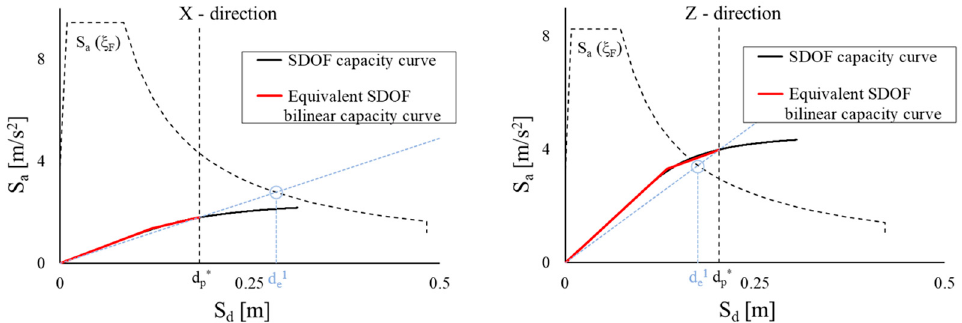
Figure 6. Comparison of the equivalent SDOF bilinear capacity curves of the four-story frame with the relevant demand response spectra in X - and Z -directions.